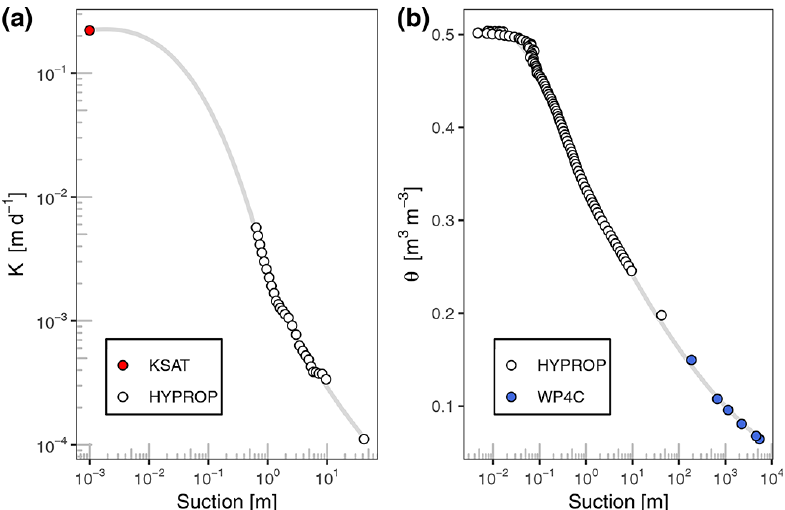
Figure 4. Plot of measured hydraulic conductivity (a) and water retention (b) for one of the topsoil ST-CC samples with the measurement instrument labeled. Gray lines are trend lines smoothed using LOESS (locally weighted smoothing).